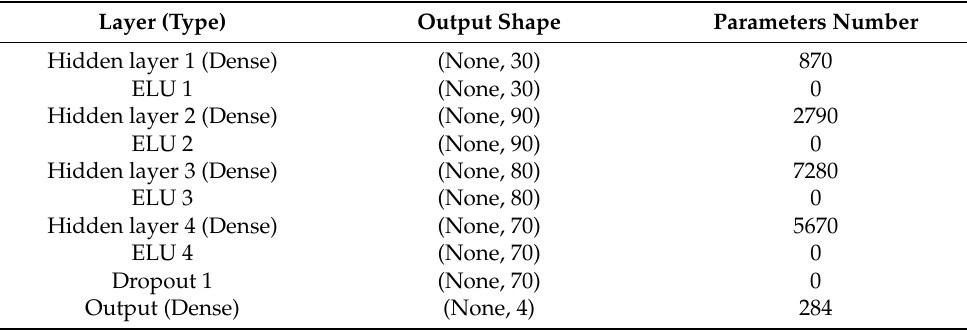
Table 1. FCDNN layer types, output shapes, and parameters number.